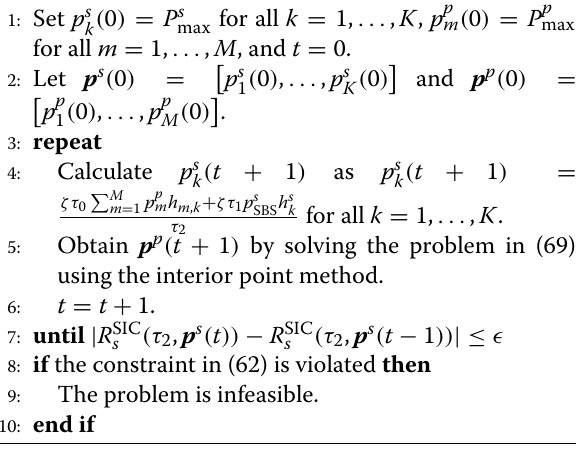
Algorithm 5 Algorithm for solving the problem in (59)